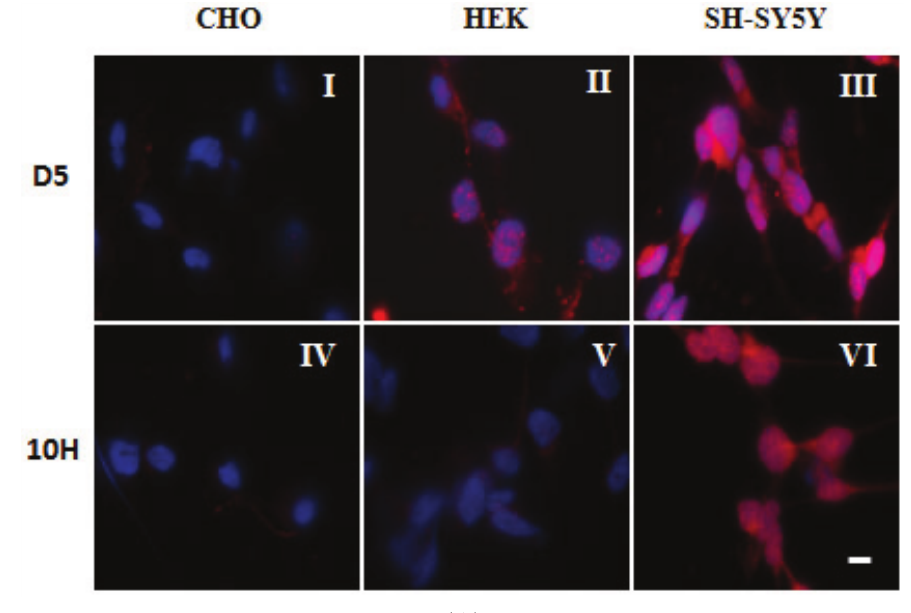
Figure 2. D5 and/or 10H scFv neutralize toxicity of different human PD brain tissue samples (PD-1 and PD-2 mix) toward SH-SY5Y cells. SH-SY5Y cells were treated with PD patient brain homogenized supernatants (200 μg/mL) with or without different concentrations of D5 or/and 10H scFvs (0.28, 0.55, 1.38 and 2.76 μM) for 24 h with medium. NC is the no cell baseline value. PC (Positive control, healthy SH-SY5Y cells treated with control brain tissue, 200 μg/mL). 2.76 + CS is the antibody control group treated with PD patient brain homogenized supernatants (200 μg/mL) and 2.76 μM of a control scFv. Cell viability was determined by the XTT assay. Cell viability is expressed by the mean of three measurements ± 1 standard deviation. Statistical significance was determined between different groups. * is p <